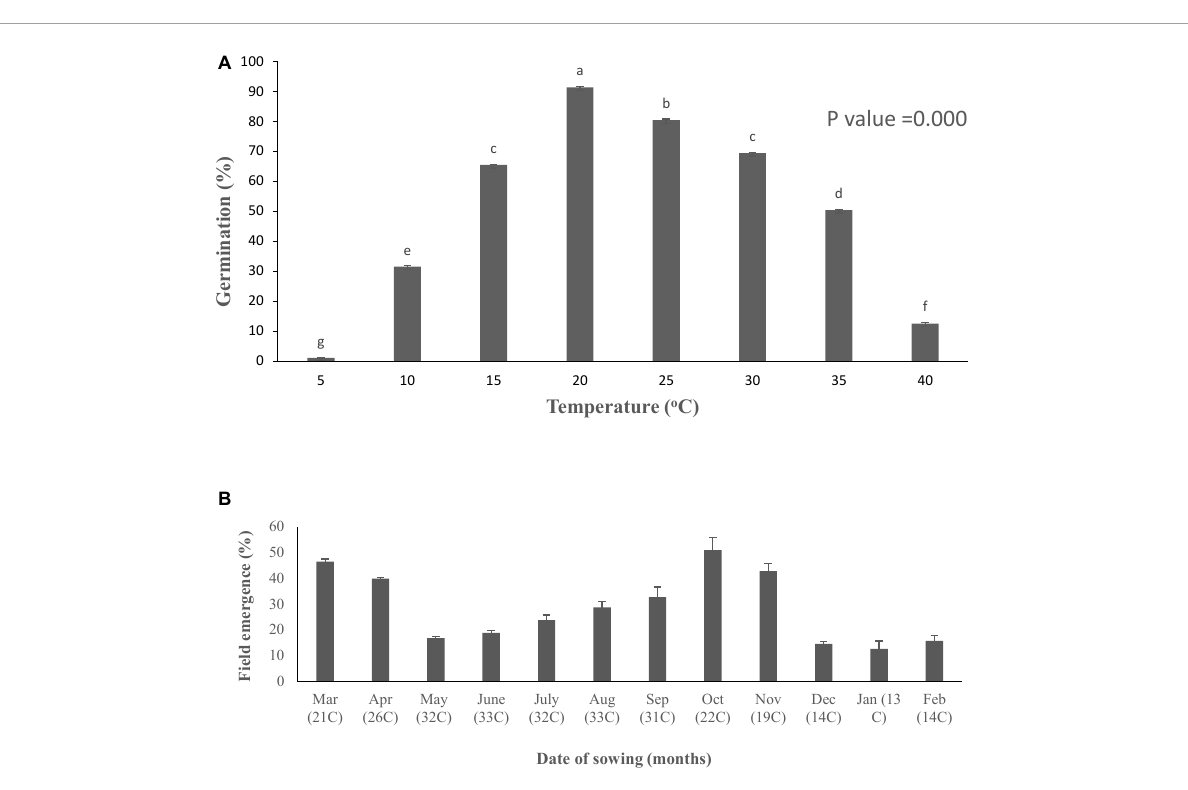
FIGURE1 Germination potential (A) at different constant temperatures under lab and field emergence (B) of Parthenium hysterophorus during years 2019–20. Vertical bars showing different letters are significantly different. Values are means ± standard